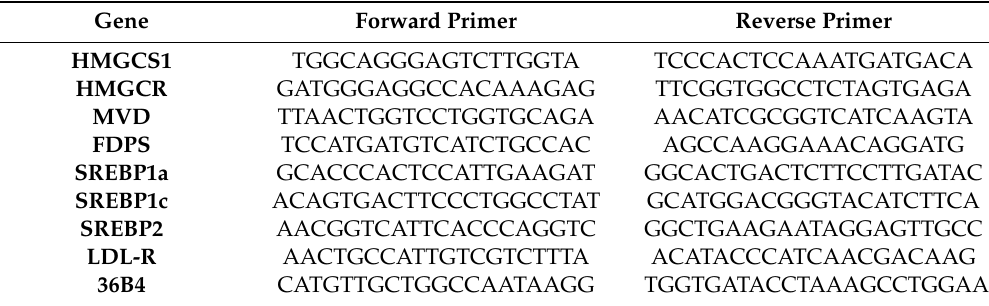
Table 1. Primer sequences for quantitative real